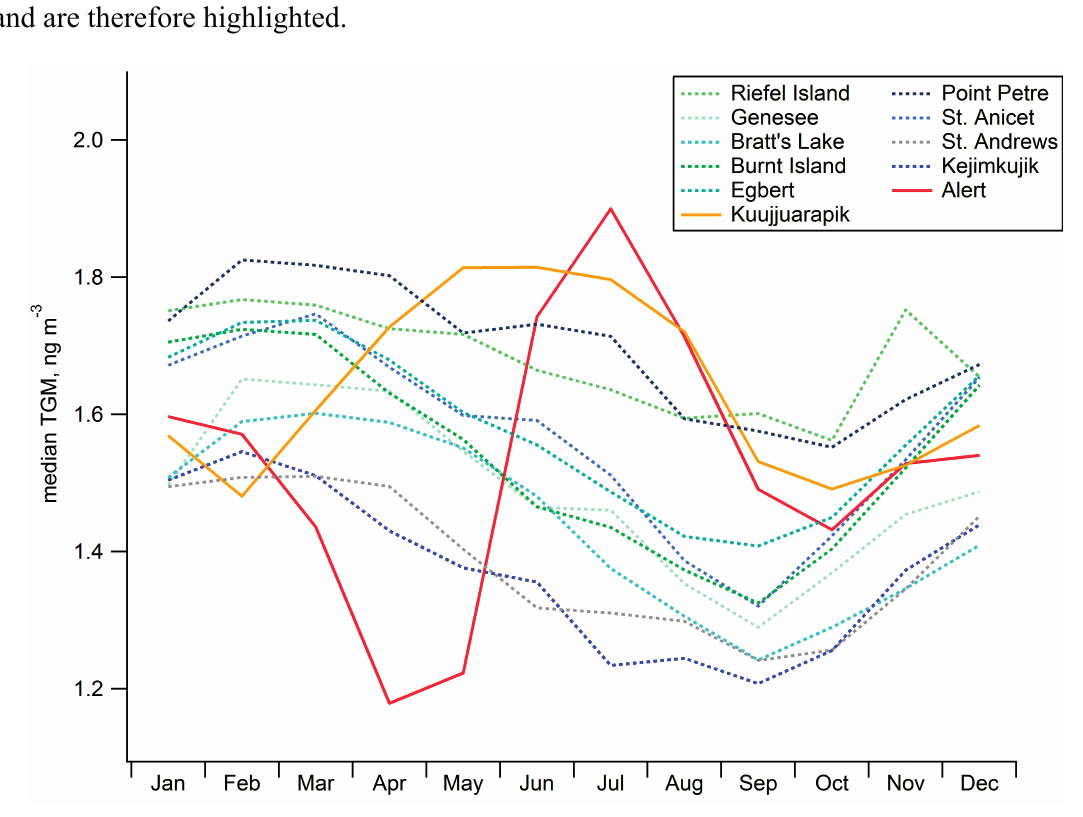
Figure 7. Seasonal cycles in total gaseous mercury (TGM) at the 11 sites with more than five years of data. Cycles from Alert and Kuujjuarapik differ from the dominant pattern and are therefore